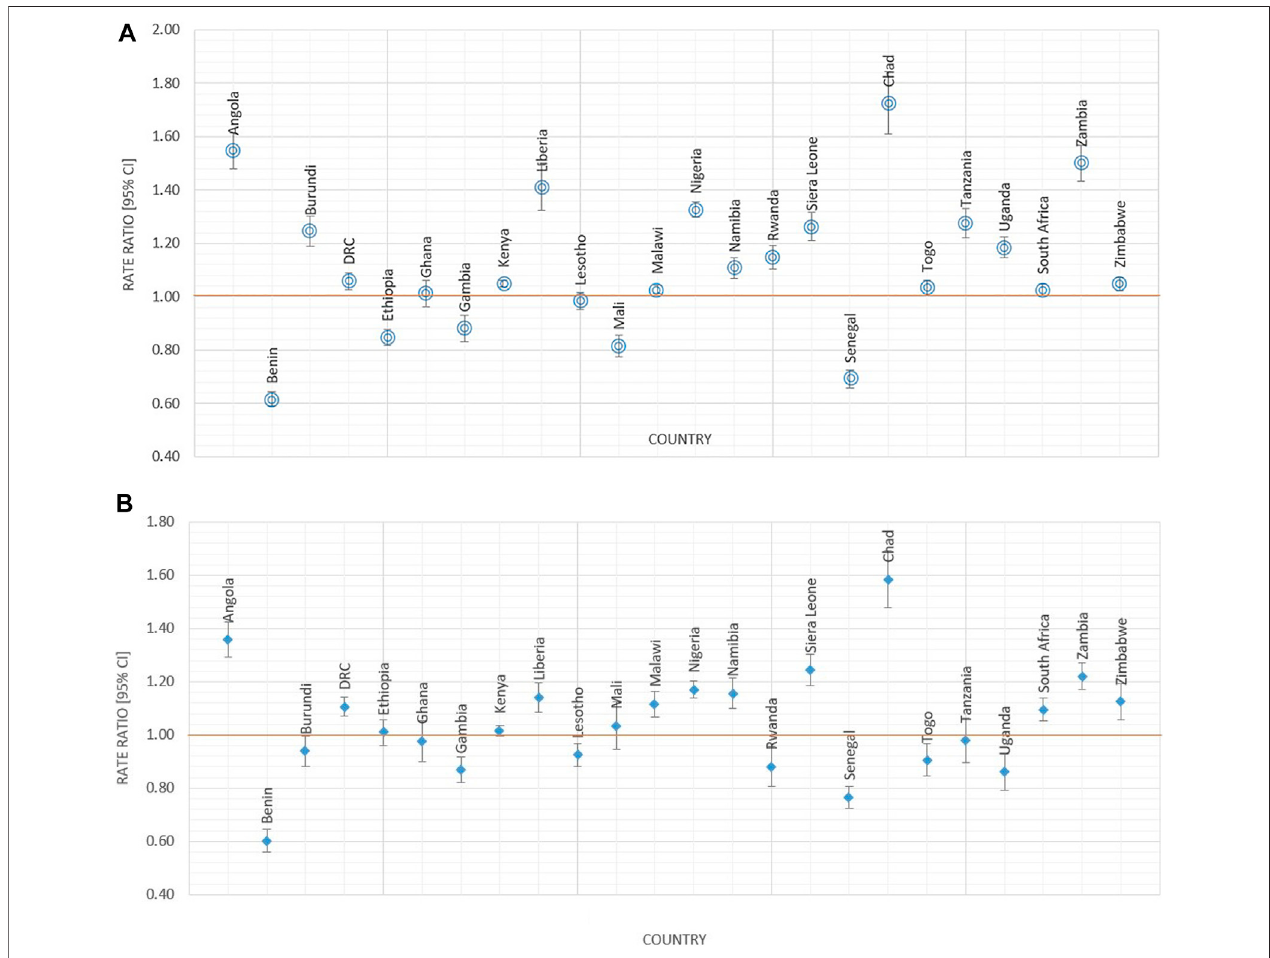
FIGURE 1 | (A) Rate ratio in school enrolment among children aged 6 – 11 years. (B) Rate ratio in school enrolment among children aged 12 – 17